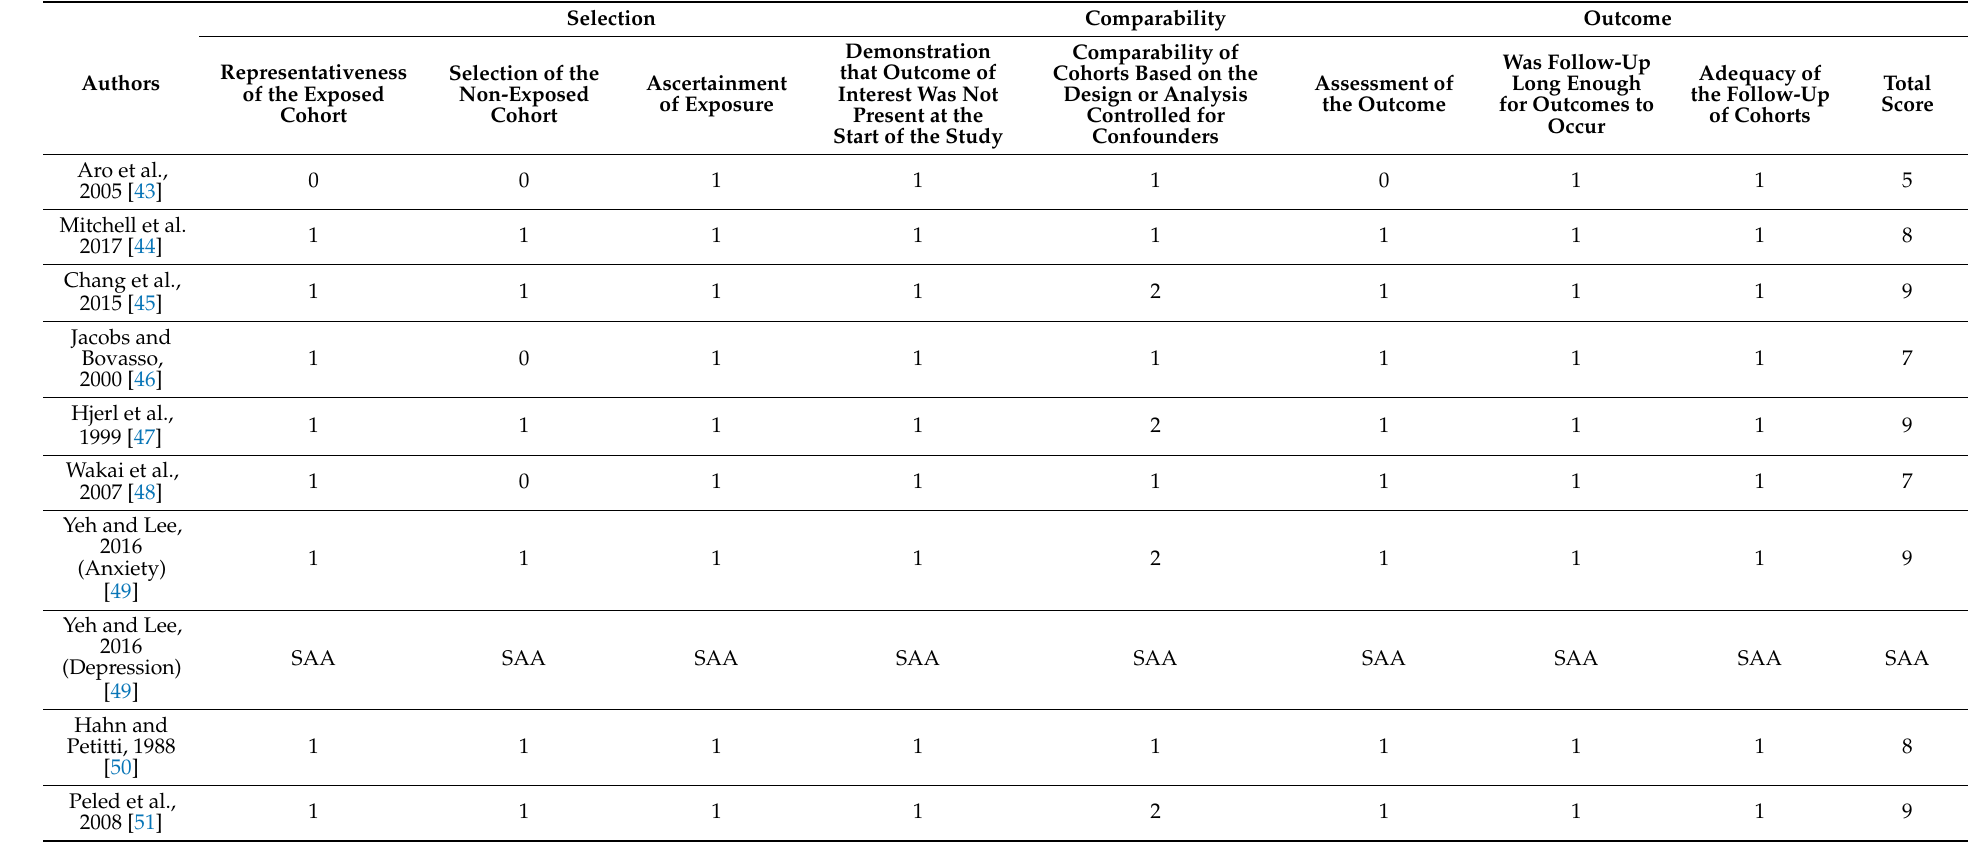
Table 1. Newcastle-Ottawa Quality Assessment Scale of the